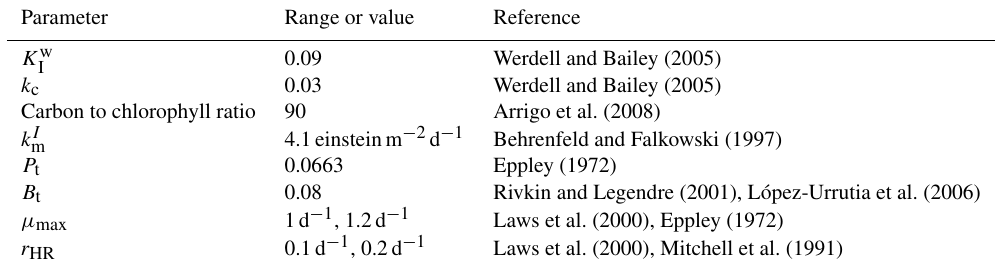
Table 1. Value or range of values with references for the parameters used in the